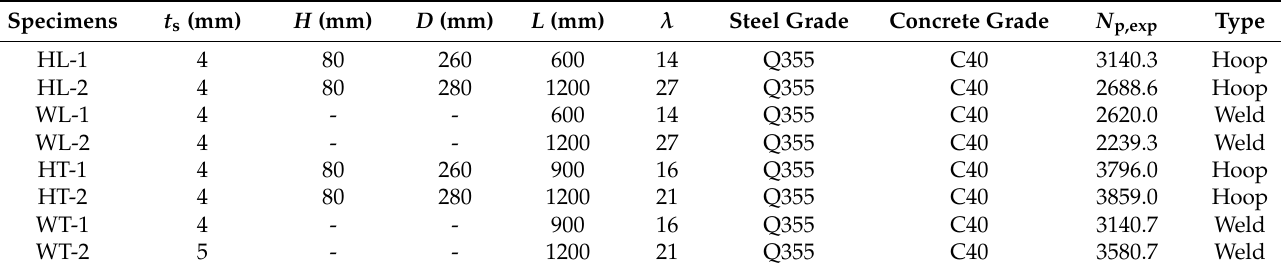
Table 1. Main design